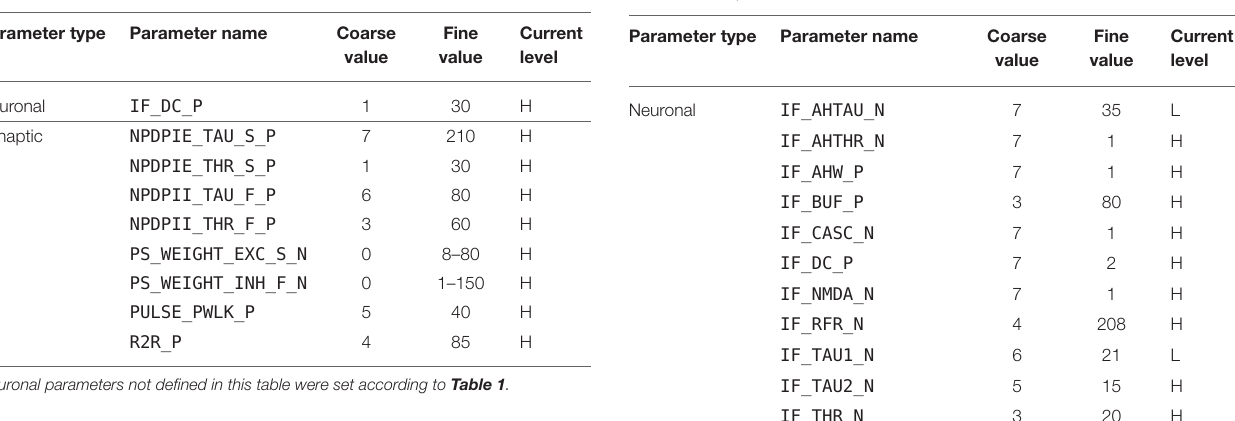
TABLE 3 | Bias parameter values used for the inhibitory neuron, LN2, in the DYNAP-SE implementation of the cricket feature detection